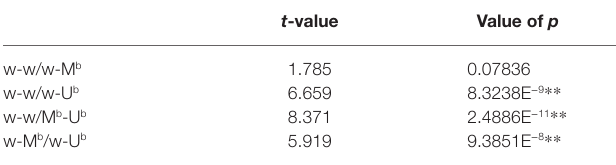
TABLE 5 | Results of t -tests describing differences in the means of various associations involving wheat (w) and Aegilops (M b , U b ) chromosomes in the